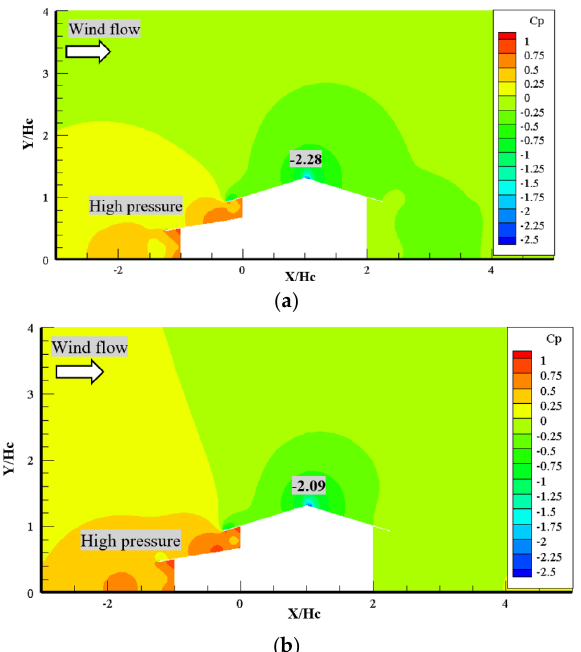
Figure 12. Pressure distribution profiles based on the kitchen location: ( a ) edge and ( b ) center.